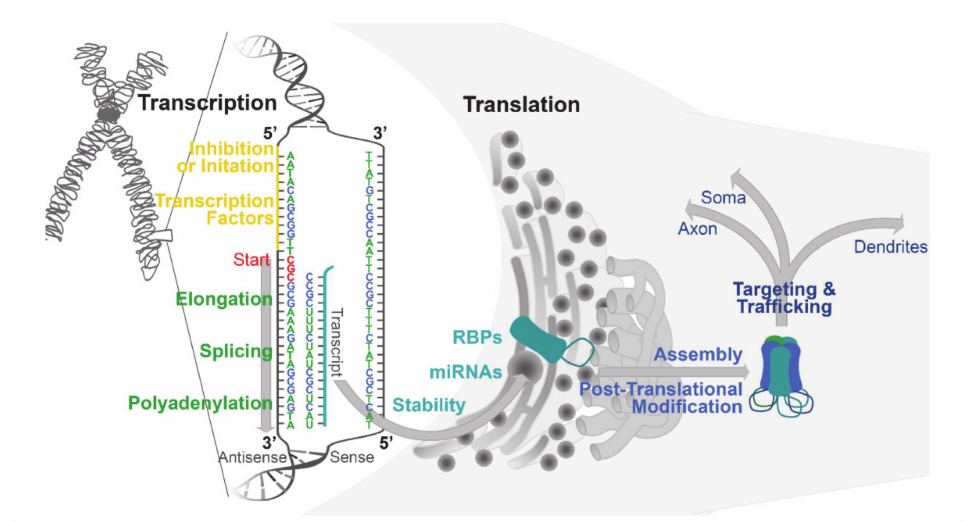
Figure 1. Levels of regulation impacting GABA A R expression and function. Expression of a GABA A R subunit begins with the initiation of transcription, which is controlled by a multiprotein complex that regulates the 5 (cid:48) UTR flanking genes encoding individual subunits. Transcription factors and other proteins that regulate transcription (yellow) bind to consensus sites in the 5 (cid:48) UTR and either promote or repress initiation. Many GABA A R subunit 5 (cid:48) UTRs contain consensus sites for more than one transcription factor, as well as multiple transcription start sites (red). Additional phases of splicing and polyadenylation (green) occur in the nucleus prior to the shuttling of the transcript to the rough endoplasmic reticulum for translation at ribosomes (grey circles). Translation of the subunit transcripts has been shown to be regulated by RNA-binding proteins (RBPs; turquoise), as well as microRNAs (miRNAs; turquoise). Once translated, the subunits are assembled (blue) together in quaternary structure to form a functional heteropentameric GABA A R. GABA A Rs are also subject to regulation via post-translational modifications (blue) such as phosphorylation and palmitoylation, as well as regulated targeting and tra ffi cking to become preferentially localized to specific subcellular